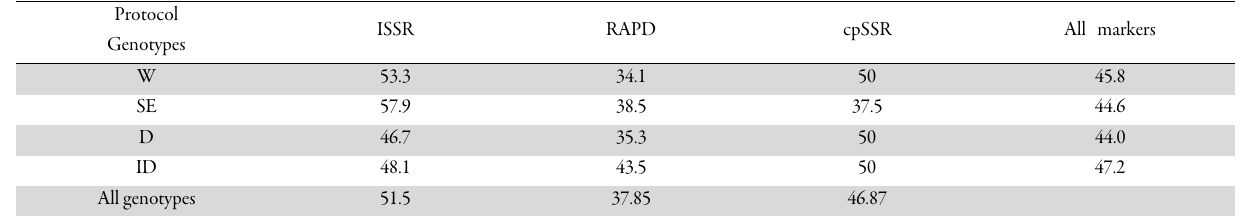
Table 5. Polymorphism percentage within studied plants groups (W= wild, SE=somatic embryogenesis, D= direct, ID= indirect organogenesis) Protocol